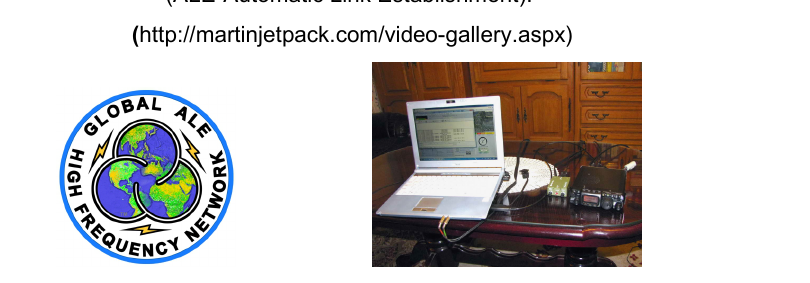
(ALE-Automatic Link Establishment). Figure 7 – Means for rapid intervention: from the air; means of communication